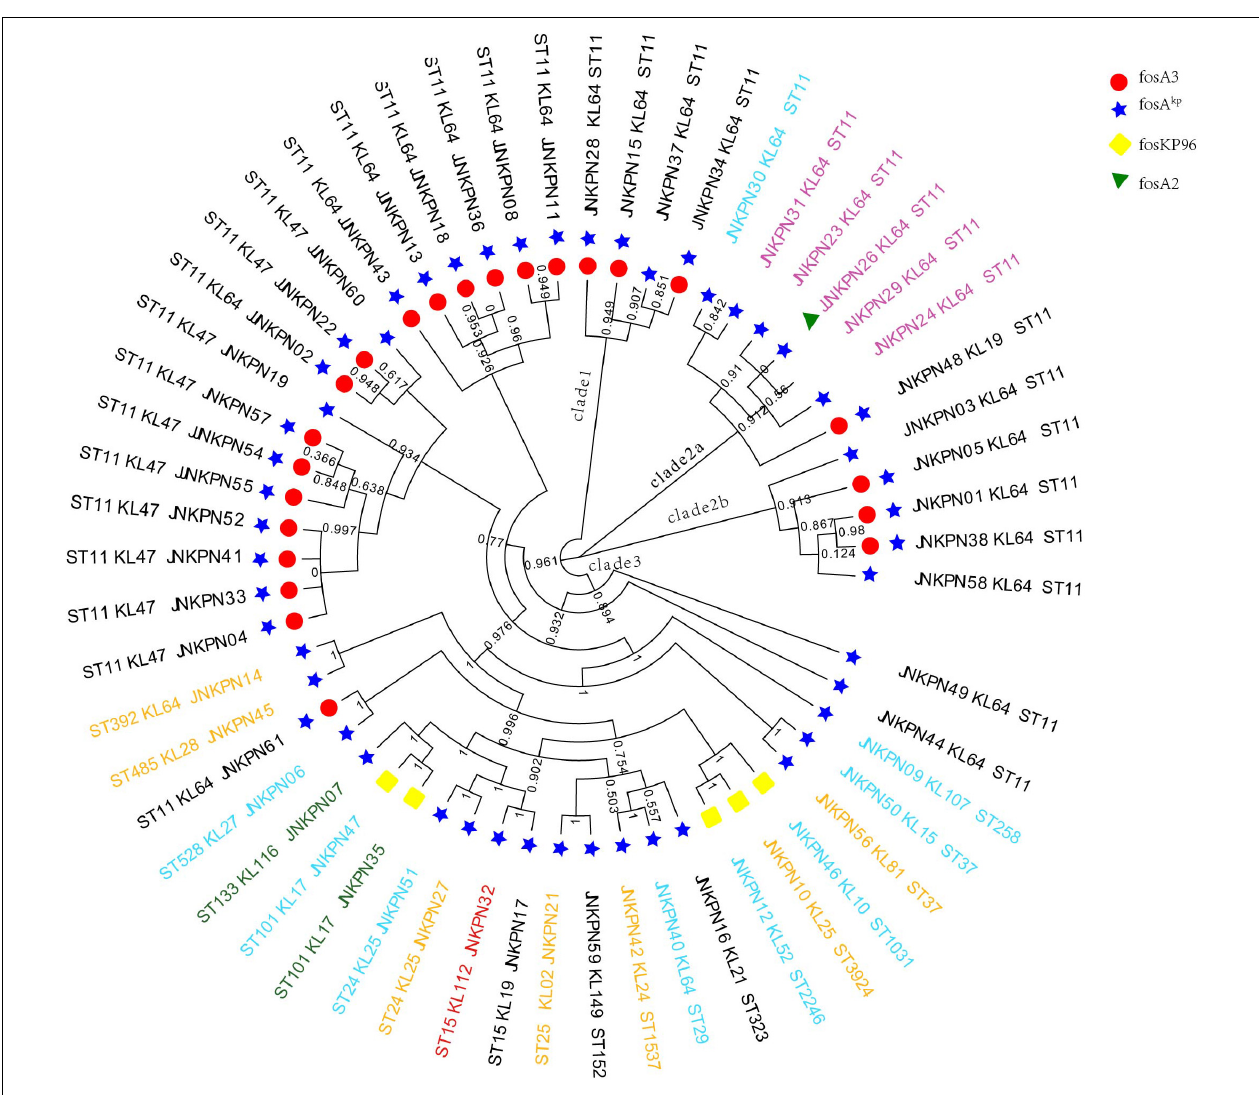
FIGURE 2 | Phylogenetic analysis of carbapenem-resistant Klebsiella pneumoniae (CRKP) isolates. The names of isolates were colored according to the carbapenemase(s) harbored, including bla KPC − 2 (black), bla NDM (blue), bla NDM and bla KPC (pink), bla IMP (green), and bla OXA − 232